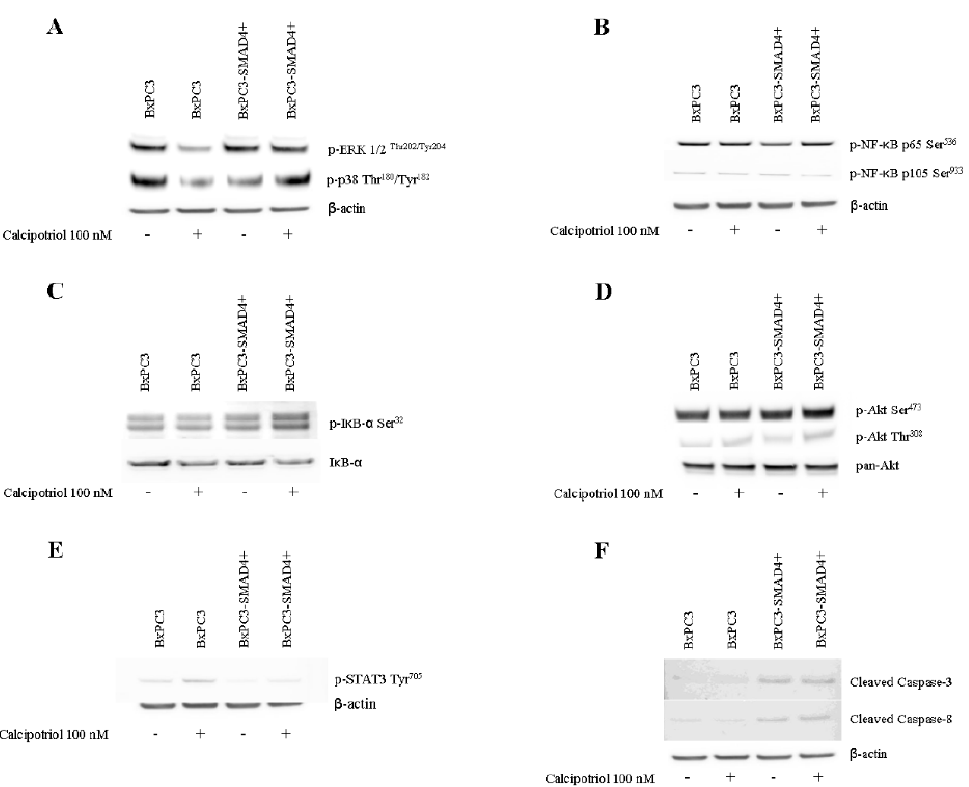
Figure 7. Western blot analyses obtained from BxPC3 or BxPC3- SMAD4+ cell lines in the presence or in the absence of 100 nM calcipotriol. Representative targets of ERK and p-38 (panel A ), NF- κ B (panel B ), I κ B- α (panel C ), PI3K/AKT (panel D ), STAT-3 (panel E ), and Caspase (panel F ) pathways are shown.